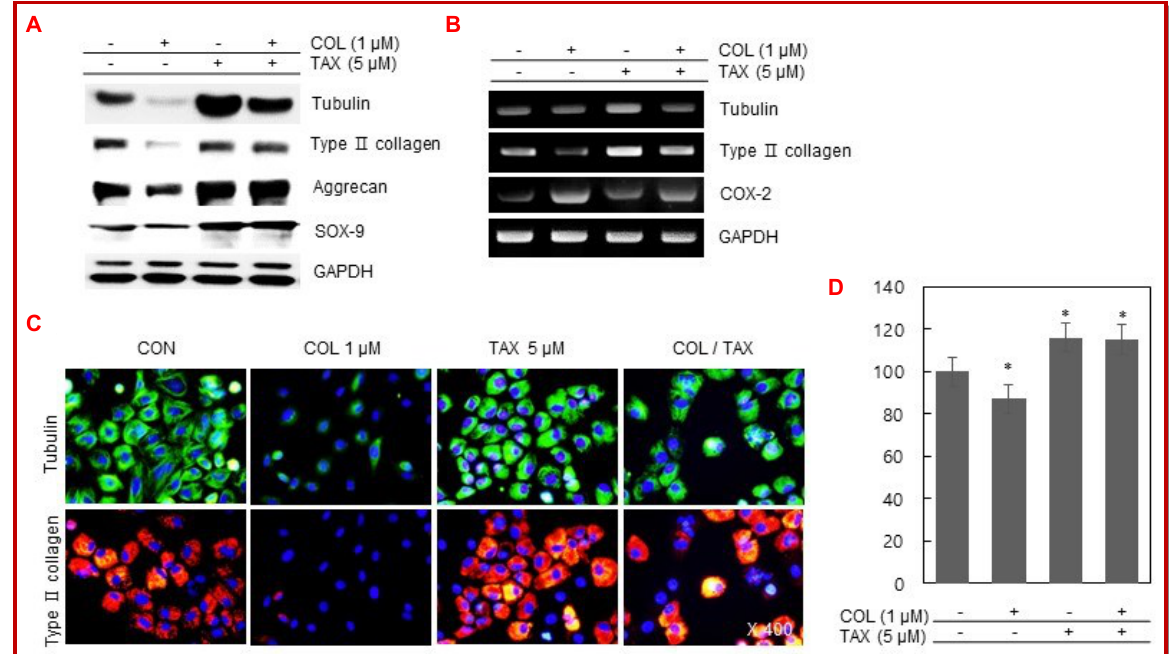
Figure 3: Regulation of microtubule synthesis controls the differentiation of chondrocytes and expression levels of COX-2 Chondrocytes were either left untreated or pre-treated with 5 M taxol for 2 hours before being exposed to 1 M colchicine for 24 hours (A, B, and C). (A) Immunofluorescence labeling was used to identify the expression of type II collagen and tubulin. Cells were labeled with a particular antibody (red or green) and DAPI for nuclear staining (blue). 400 times magnification; (B and C) Western blot analysis (B) was used to assess the expression of tubulin, type II collagen, aggrecan, SOX-9, COX-2, and GAPDH. Reverse transcriptase-polymerase chain reaction (RT-PCR) was used to identify the expression of tubulin, type II collagen, COX-2, and GAPDH (C). We used GAPDH as a loading control. (D) Alcian blue staining was used to assess how sulphated proteoglycans were synthesized. The data are the average values, plus standard deviation, from at least four independent studies; *p < 0.05 in comparison to the control group. The data in (A, B, C, and D) indicate the outcomes of a typical experiment, whereas the data in (D) repre- sent mean values with standard deviation. *p<0.05